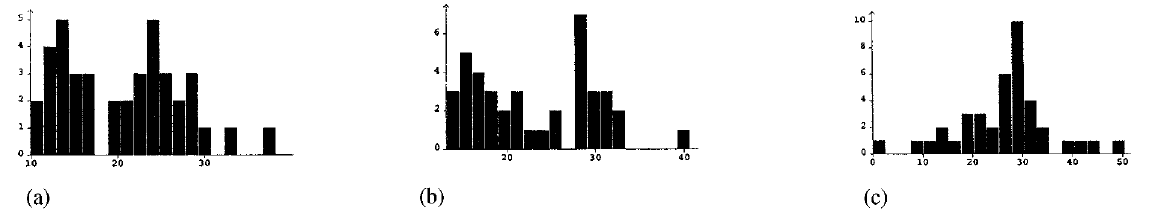
Fig. 3. Value of relative positive areas for detection of PCNA using LAB/LAB (a), PAP/APAP (b) and dig–a-dig/PAP (c)